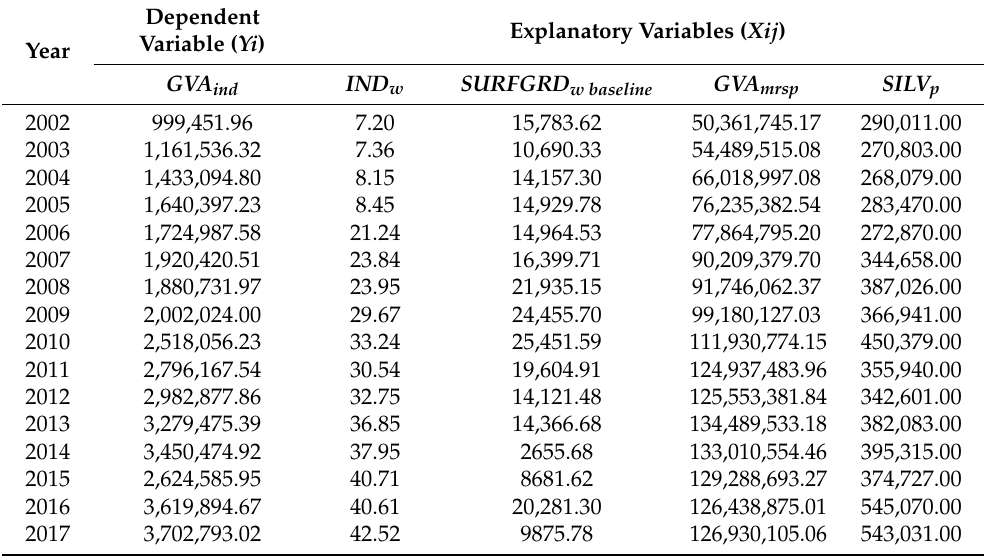
Table 3. Values of the dependent and explanatory variables used in the industrial GVA model